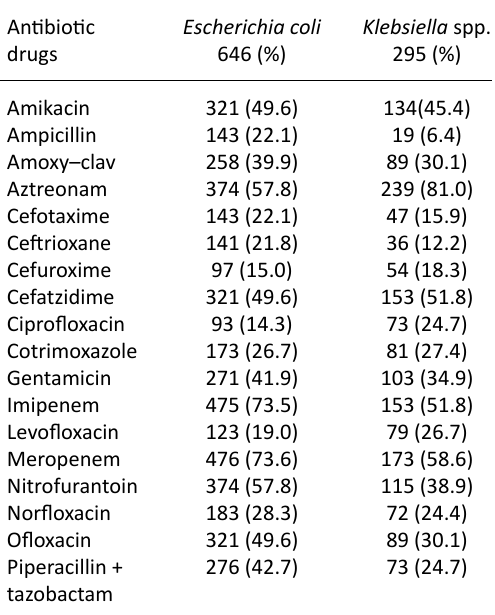
Table 2. Antimicrobial susceptibility pattern of isolated organisms